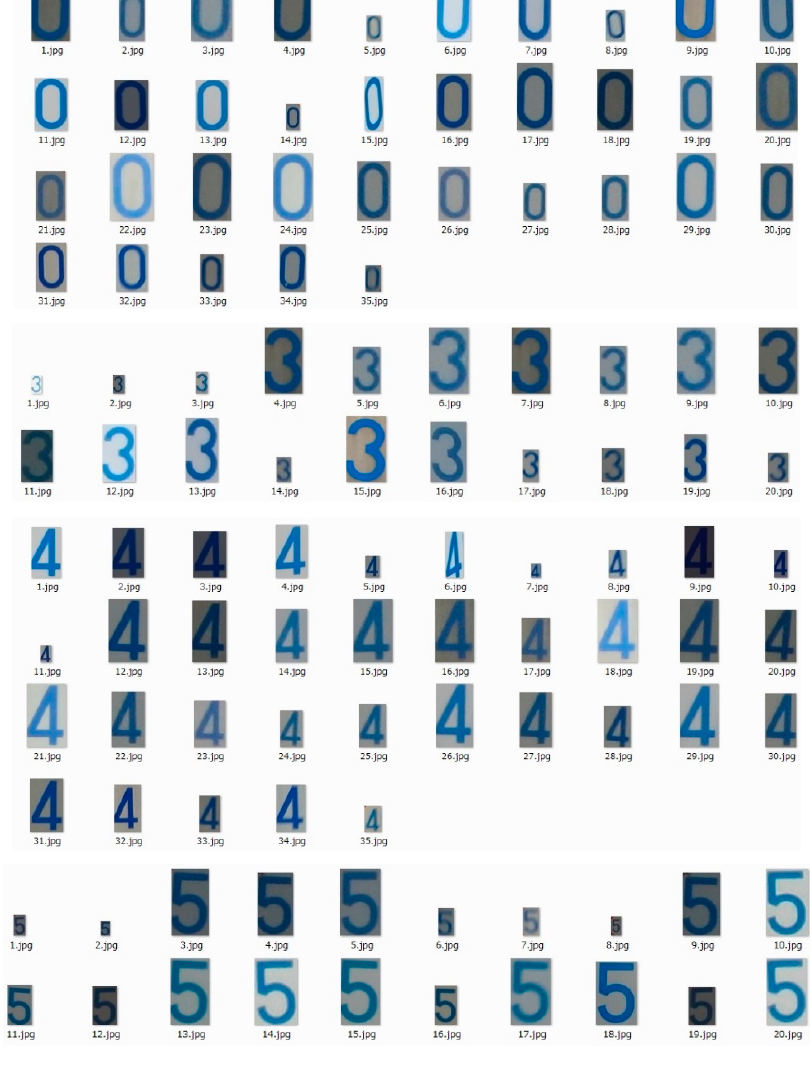
Figure 10. Training images for Number 0, 3, 4, 5 cut out from the images acquired from the camera.